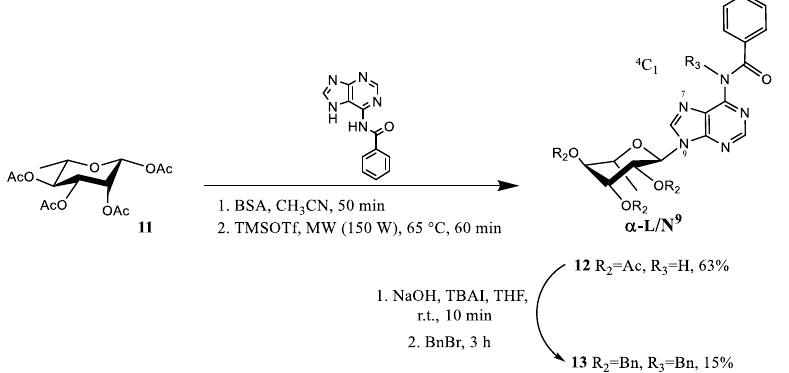
Scheme 3. Synthesis of nucleosides 15 and 16 , obtained by microwave-assisted reaction of glycosyl donor 14 and activated purine base catalyzed by TMSOTf, with conformations given by computa- tional studies in agreement with NMR data. Both the anomer configuration and the ligation at N 7 or N 9 were determined based on 1 H and 13 C NMR data and COSY, HMQC, and HMBC experiments. The chemical shift of purine carbon 5 is characteristic and permits to distinguish between the kinetic regioi- somer N 7 and the N 9 thermodynamic one [19]. These values were between δ 118 and 112 ppm for compounds 7 and 8 (N 7 isomers), while ligation at N 9 resulted in chemical shifts of C- 5 between ca δ 129 and 122 ppm (as in compounds 5 , 6 , 9 , 10 , 12 , 13 , and 15 , 16 ). The anomeric configuration was assigned from the coupling constant 3 J 1 ′ ,2 ′ and con- firmed by COSY and NOESY experiments. The coupling constants 3 J 1 ′ ,2 ′ for compounds 5 , 7 , 12, and 15 were 8.0 Hz, 9.3 Hz, 6.3 Hz, and 7.1 Hz, respectively, thus suggesting the presence of trans -diaxial like protons as in 1 C 4 conformation for the D series and 4 C 1 for the L series. The coupling constant 3 J 1 ′ ,2 ′ of 7.4 Hz for the β -anomer ( 6 ) was unexpected, indi- cating a conformation possibly bearing H-1 ′ and H-2 ′ approaching a parallel orientation, tentatively depicted in Scheme 1. 1 H NMR spectra of the β -anomers 8 , 10 and 16 show coupling constants 3 J 1′ , 2′ lower than 1 Hz, as expected. By the NMR spectra analysis, the structures of ten nucleosides were proposed, six of them being unexpected. Usually, the most stable glycosyl conformation presents its volu- minous protecting groups in equatorial positions, which does not happen in nucleosides 5 , 7 , 9 , 12, and 15 . Moreover, compound 6 seems to present a non-usual β -conformation, and 12 ( α -anomer) was obtained as a single product. These unexpected results led us to perform computational studies, which unambiguously confirmed the proposed structures deduced from NMR data. Figure 2 and Tables S1 – S7 in Supplementary Materials show the comparison of experimental and calculated NMR data, and the formation of 12 as a single product (Table 2) was unambiguously confirmed. The tables comparing